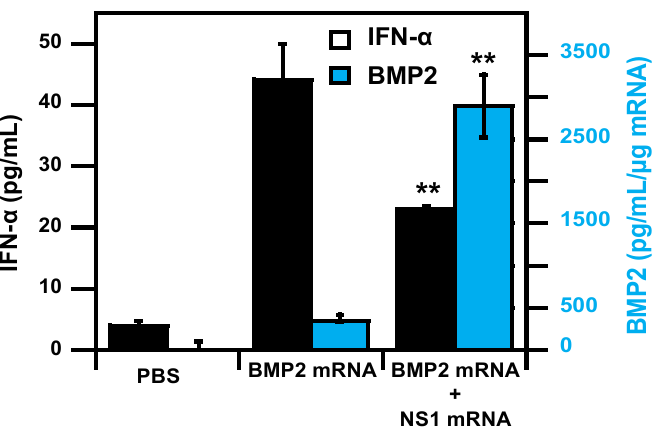
Figure 8. Co-transfection of osteoprogenitor cells with BMP2 mRNA and NS1 mRNA resulted in decreasing type I interferon response together with enhanced therapeutic BMP2 mRNA expression. Adapted from [132], Elsevier, 2021, with permission. ** represents p <